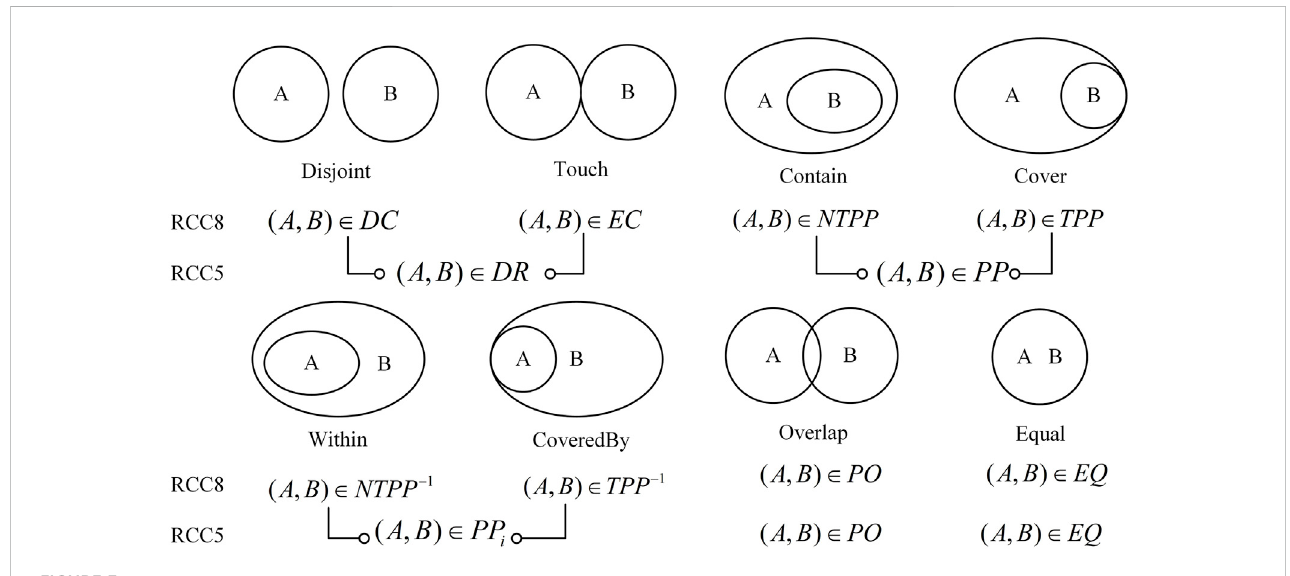
FIGURE 3 The basic topology relations based on RCC5 and RCC8.